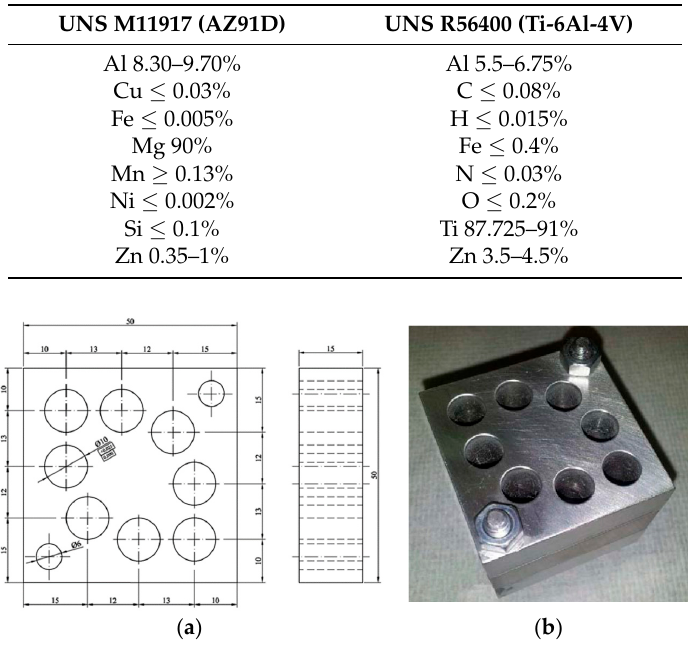
Figure 2. ( a ) Design of the geometry of each of the three parts of the workpiece; ( b ) Predrilled workpiece